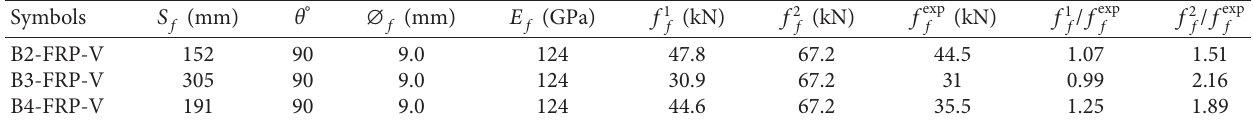
Table 3: Comparison between experimental results [111] and analytical